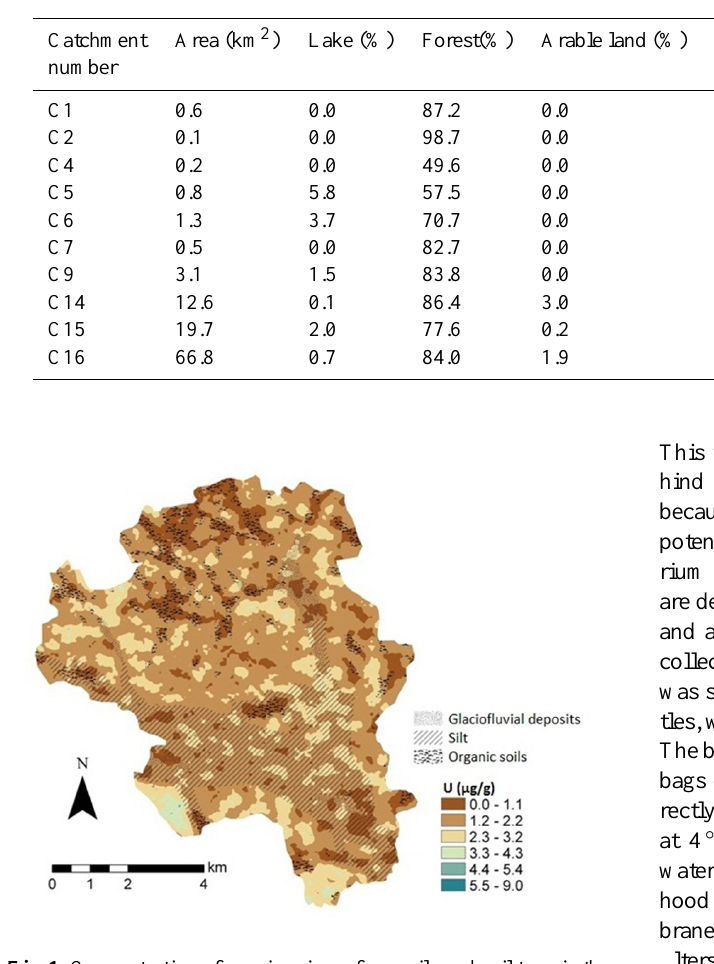
Fig. 1. Concentration of uranium in surface soils and soil type in the Krycklan catchment (SGU, consent Dnr: